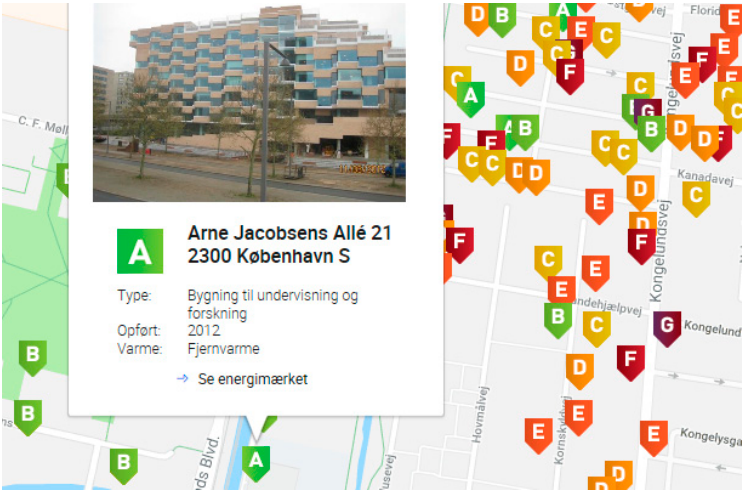
Figure 2. Publicly accessible part of the Danish EPC Database (Screenshot). https: // sparenergi.dk / forbruger / vaerktoejer /